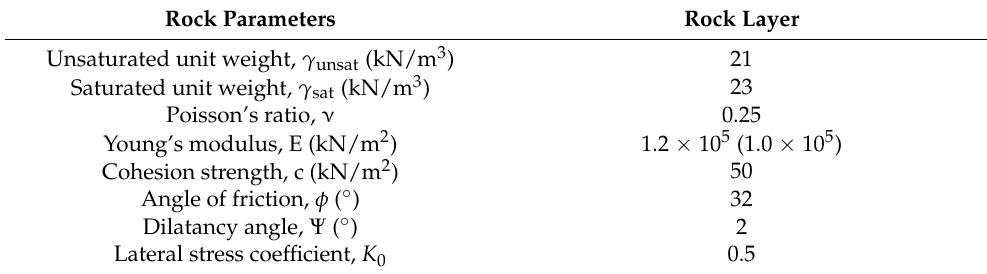
Table 1. Parameters for the Mohr–Coulomb model (with rock bolts and pipe roofings installed).